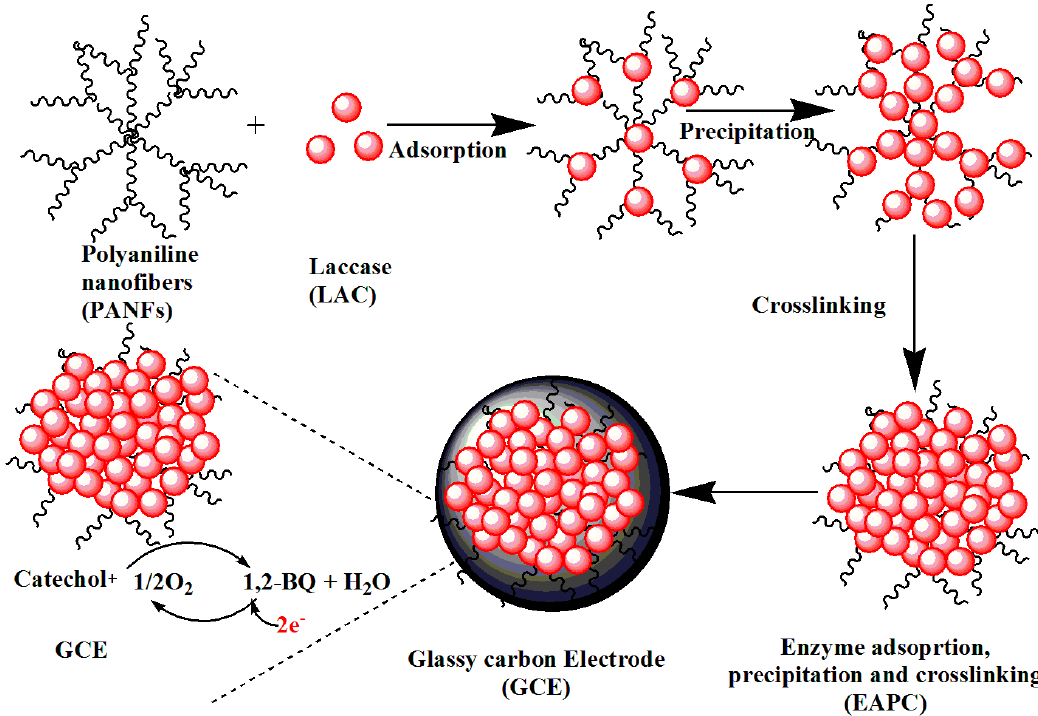
Figure 2. Enzyme immobilisation by adsorption method [36].